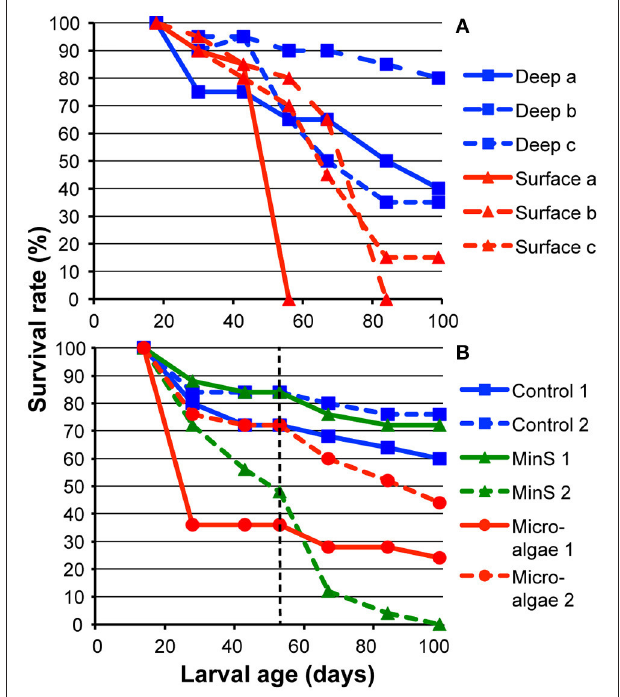
FIGURE 1 | Survival rates of L. pertusa larvae treated in culture flasks at 7–8 ◦ C. Controls contained filtered (5 µ m) deep-sea water with a salinity